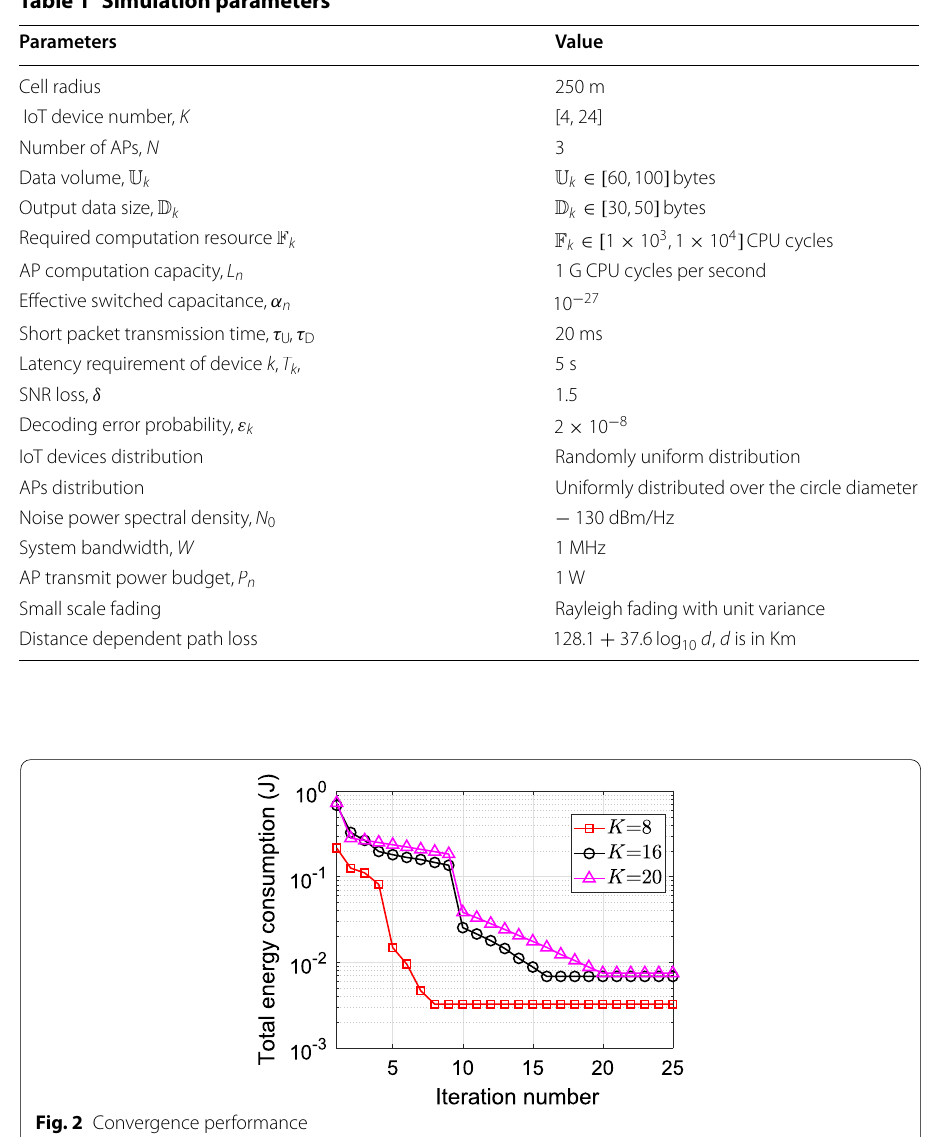
Table 1 Simulation